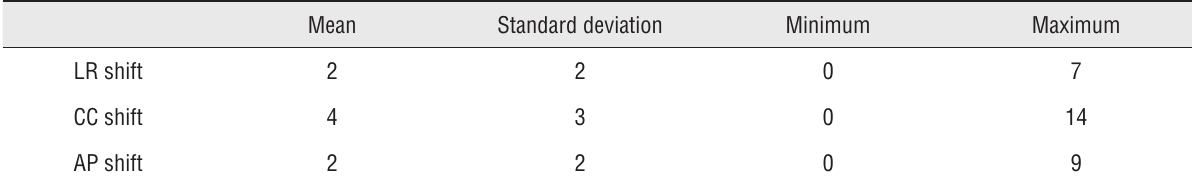
Table 2 - Daily patient shifts (mm) using Lipiodol for